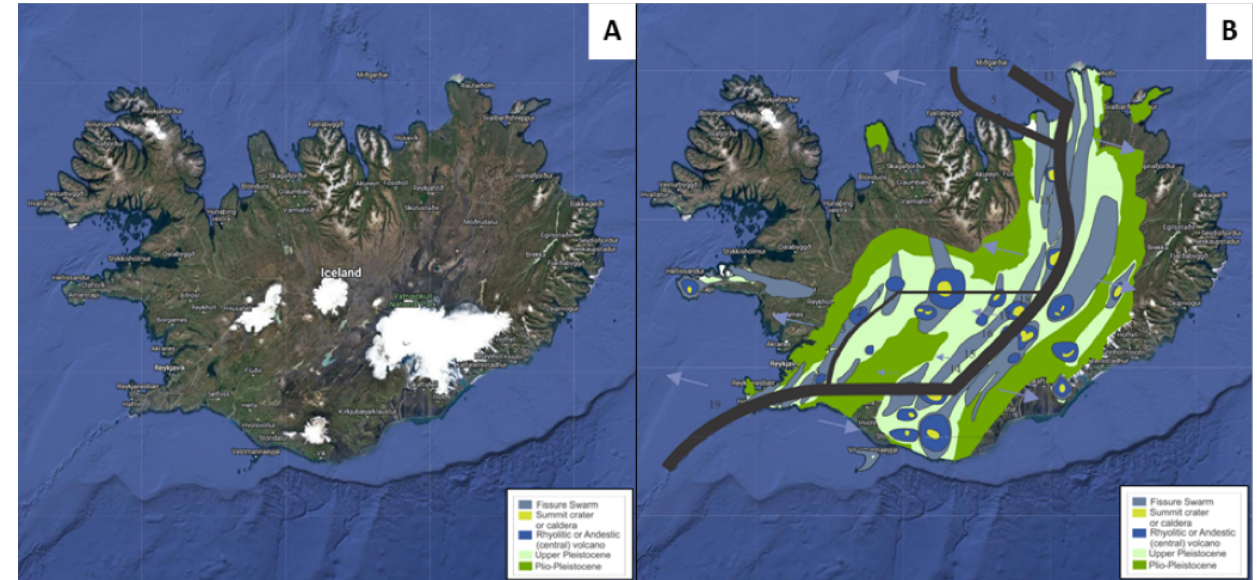
Figure 2: [A] Map of Iceland with volcanic overlay; [B] Map of Iceland with tectonic